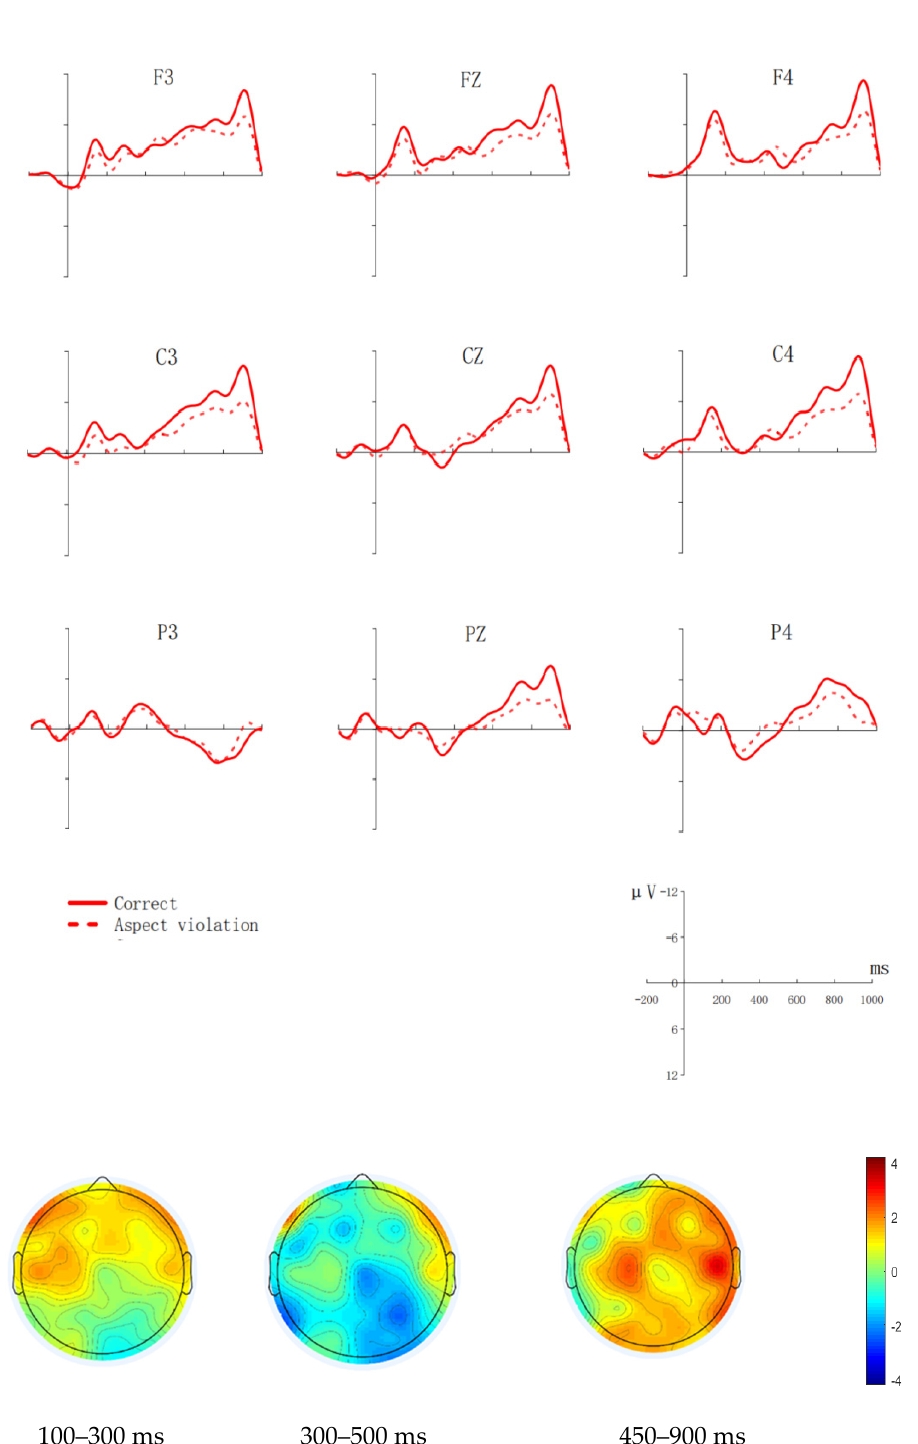
Figure 2. Grand average (N = 20, with 20 valid samples) ERPs of the Indonesia group at 9 exemplar electrodes time-locked to the onset (0 ms) of the aspect marker “ le ” as a function of aspect agreement. The x -axis represents the duration, and each hash mark represents 200 ms. The y -axis represents the voltage, which ranged from − 12 to +12 µ V. Negativity is plotted upward. The topographical voltage map represents the difference waves effects (the aspect violation condition minus the correct condition) at 100–300 ms, 300–500 ms, and 450–900 ms,